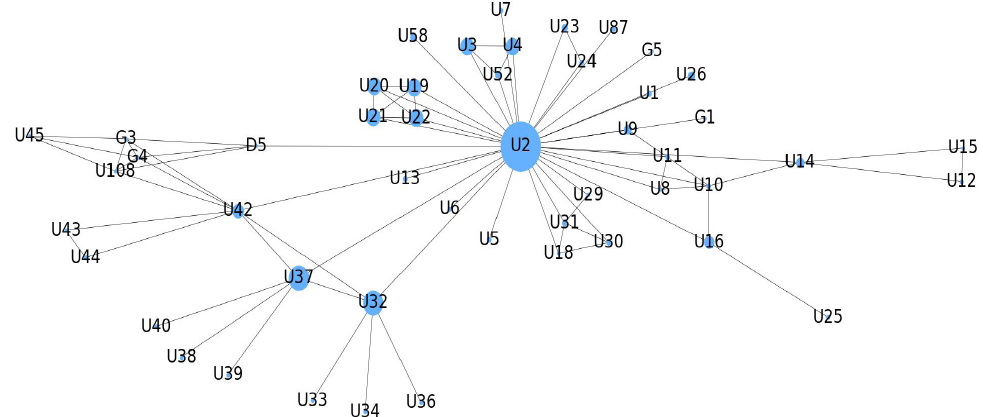
Figure 1. Schematic diagram for initial partitioning by cutting important attribute